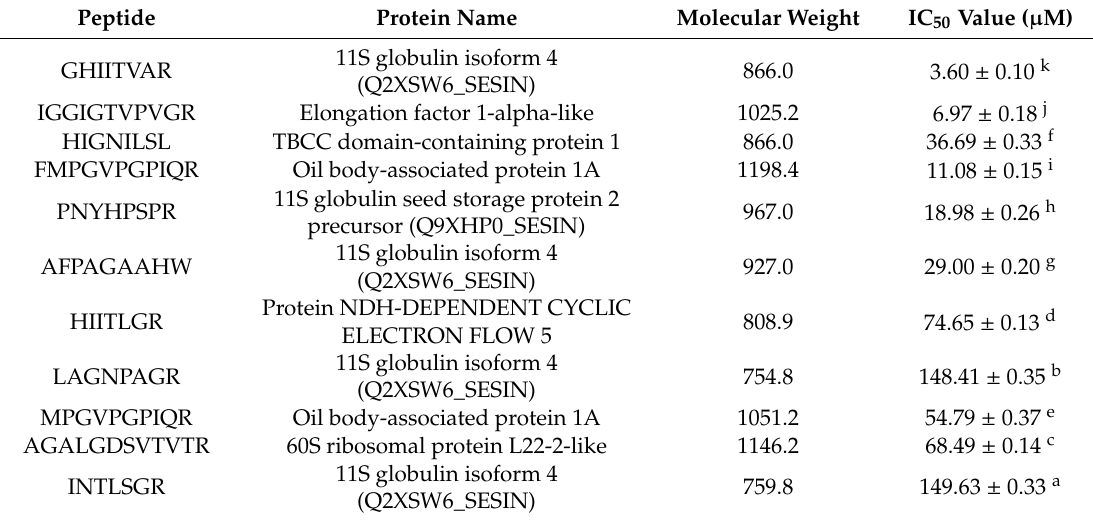
Table 3. Peptides identified from peak 4 and corresponding physicochemical characteristics.